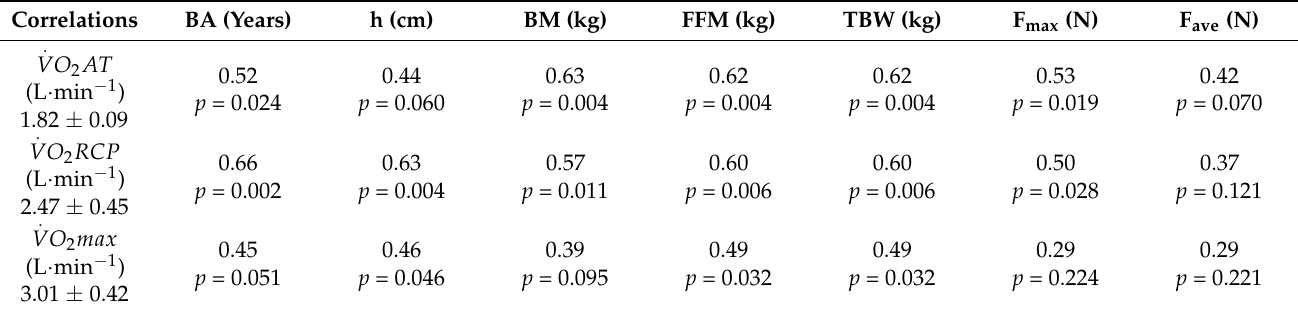
Table 3. Correlations of stage test physiological and kinematic indices: body composition indices.